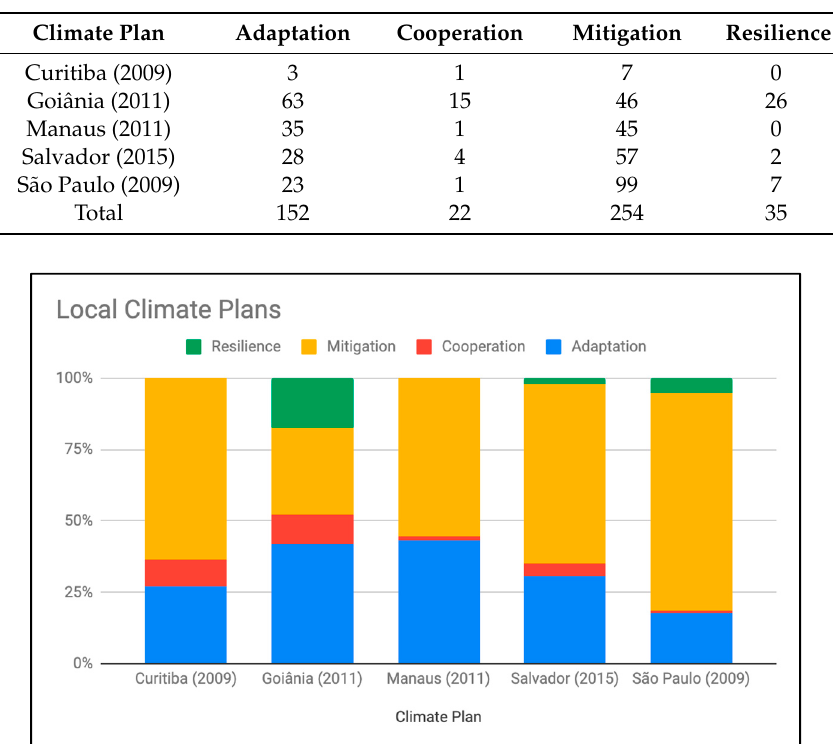
Table 6. Climate action references in local climate plans.